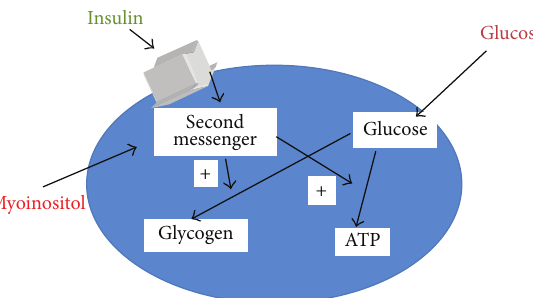
Figure 1: Mechanism of action of myoinositol in the cell.